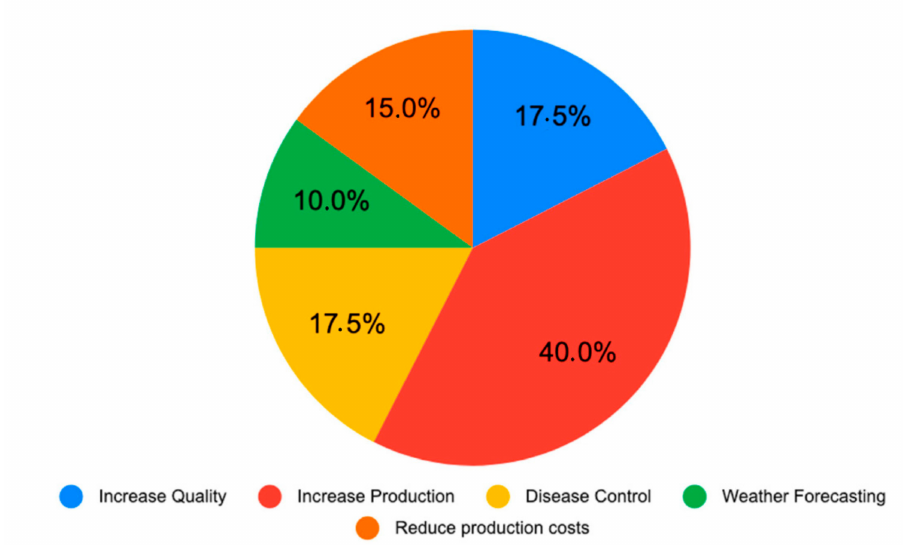
Figure 6. Distribution of papers selected by Problem